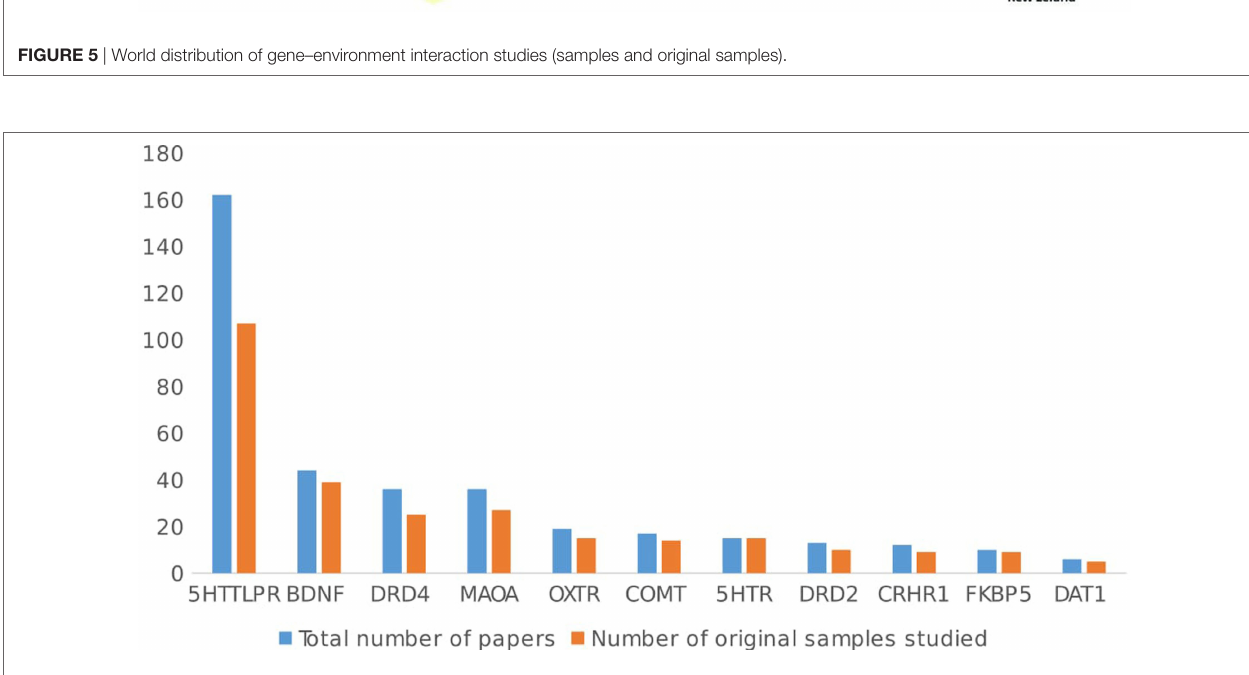
FiGURe 6 | Overlap between study samples by gene.